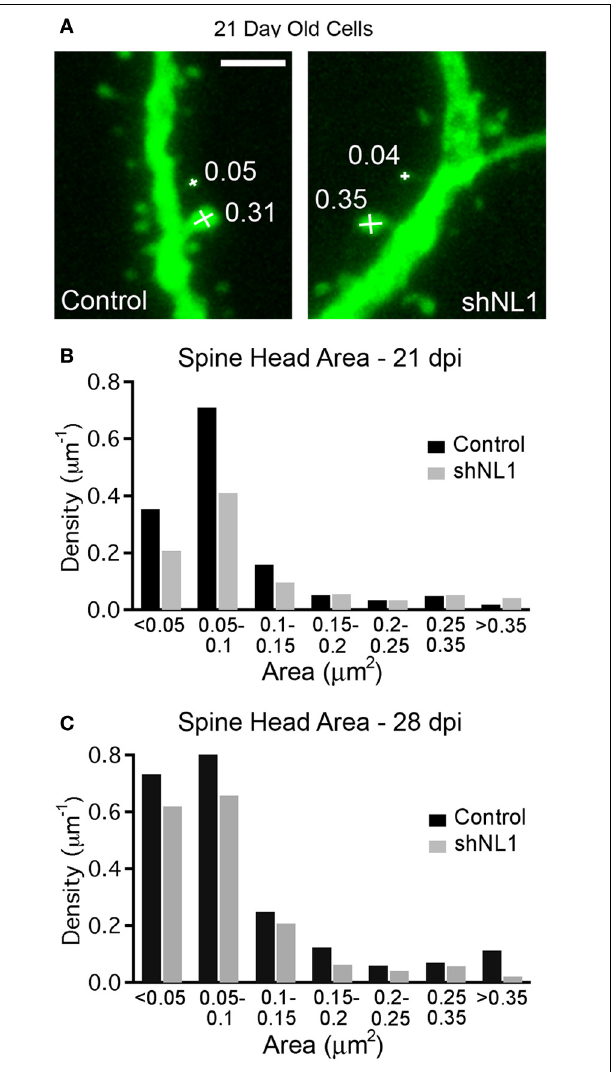
FIGURE 1 | Neuroligin-1 knockdown reduces dendritic spine density in immature adult-born granule cells. (A) Representative dendritic segments from retroviral vector control (top) and neuroligin-1 shRNA injected cells (shNL1; bottom) 21 days after mitosis. (B) Summary graph of dendritic spine density in the dentate middle molecular layer for each condition (control, n = 5; shNL1, n = 7; ∗ p < 0 . 05), with individual data points plotted for each condition. (C) Neuroligin-1 knockdown does not alter dendritic spine length ( p > 0 . 2).